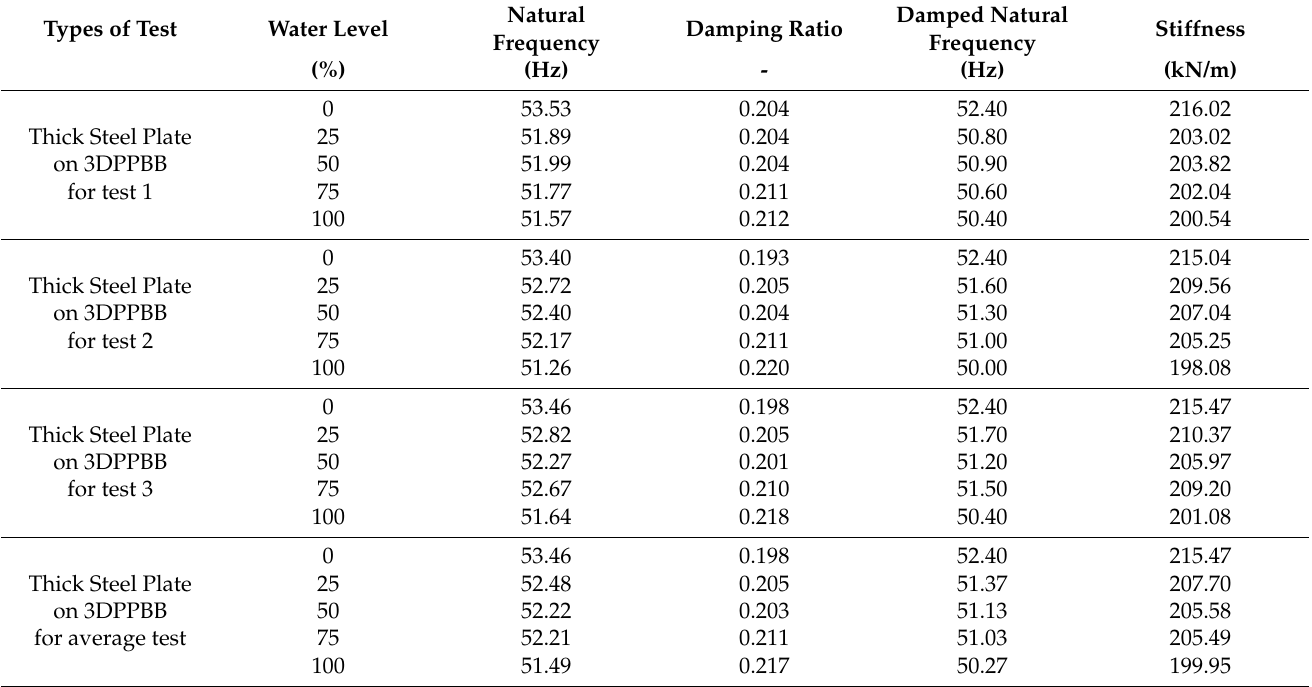
Table 3. Dynamic Modal Properties’ Variations under Various Water